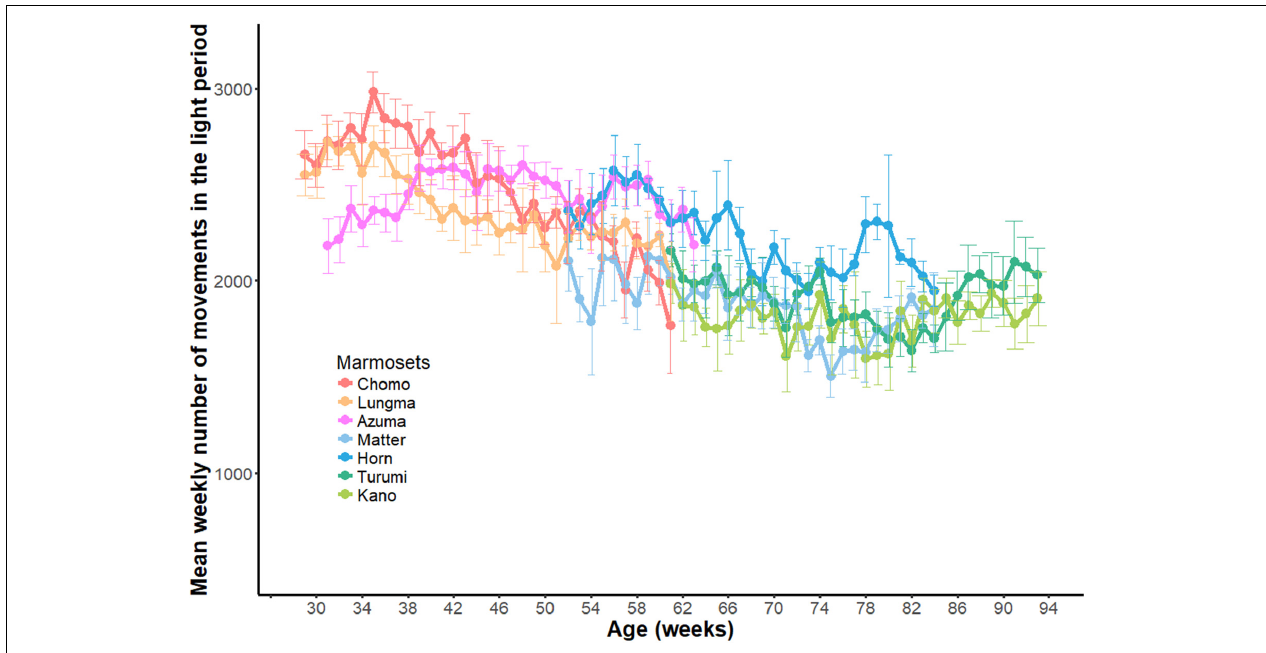
FIGURE 5 | Developmental changes in daytime activity. Longitudinal changes in daytime activities throughout the experiment period (33 weeks) for all seven marmosets. Weekly mean ( ± SD) for each marmoset was plotted against